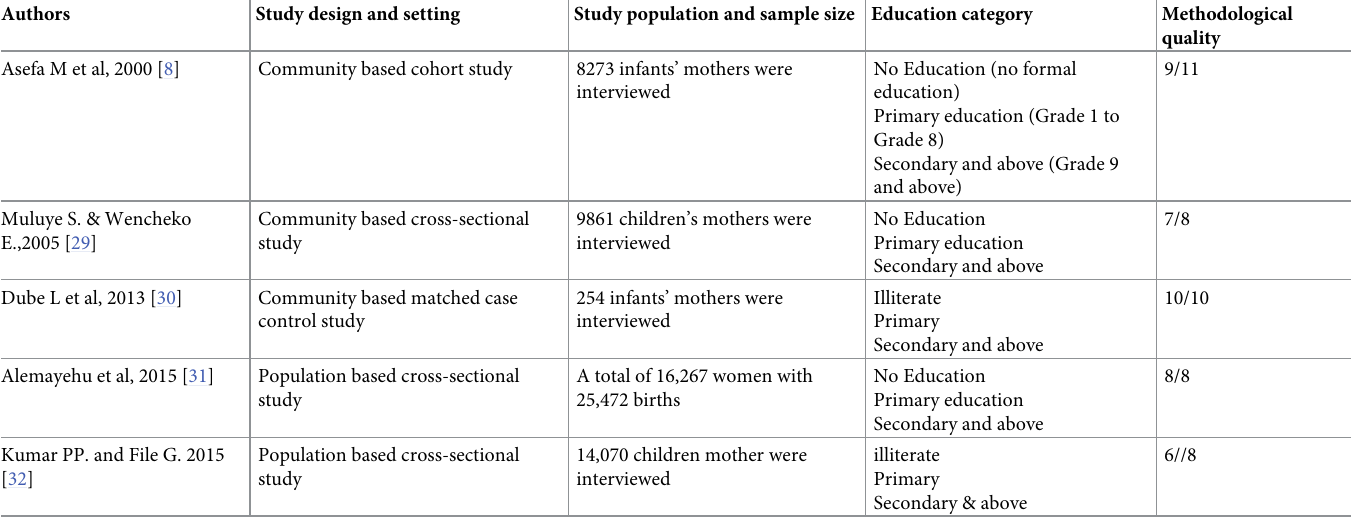
Table 1. List of studies included to show the effect of maternal education on infant mortality in